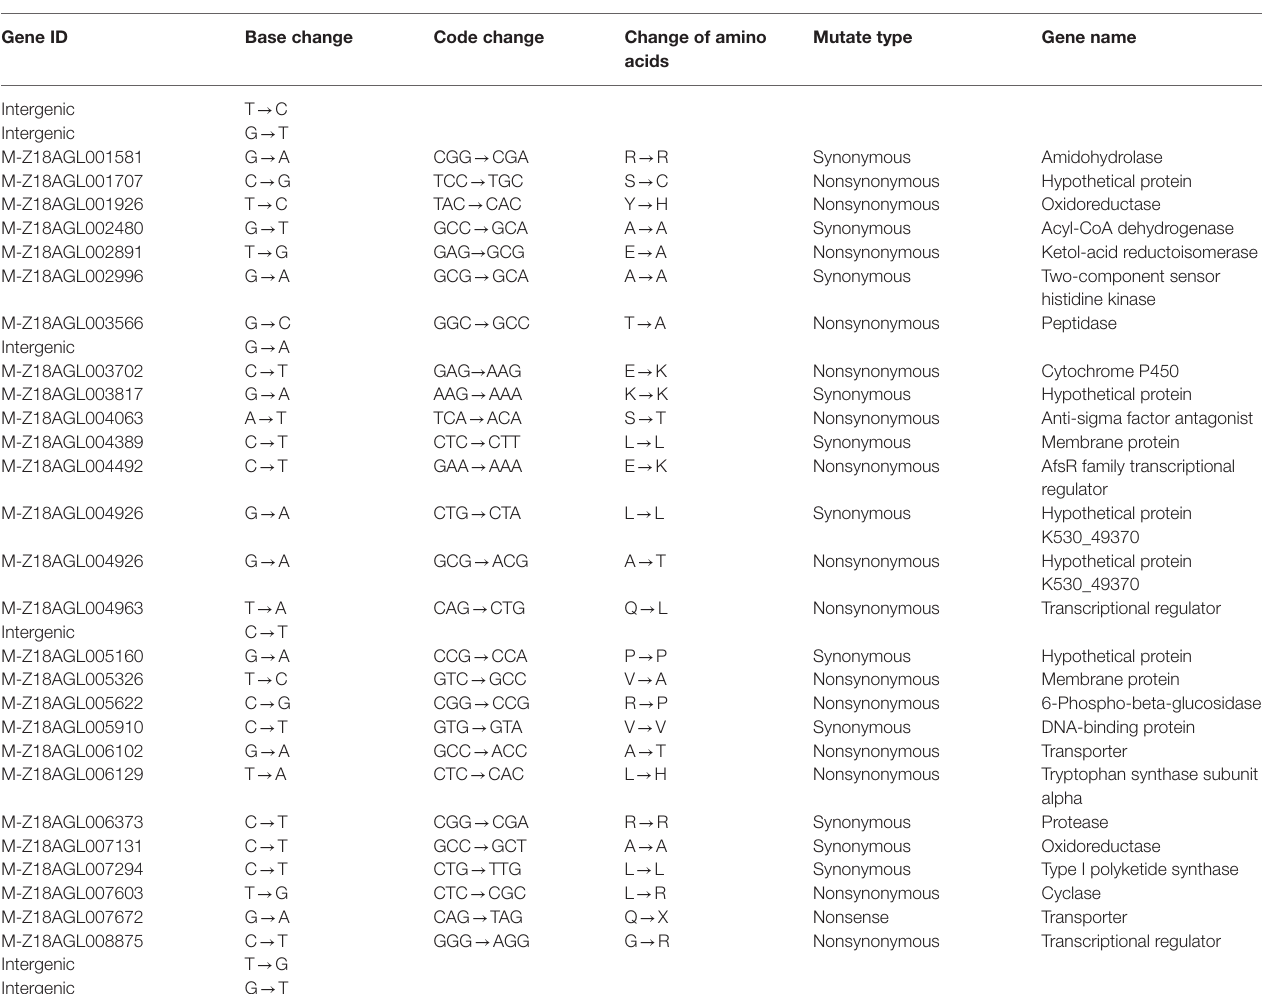
TABLE 2 | Single nucleotide mutation of recombinant